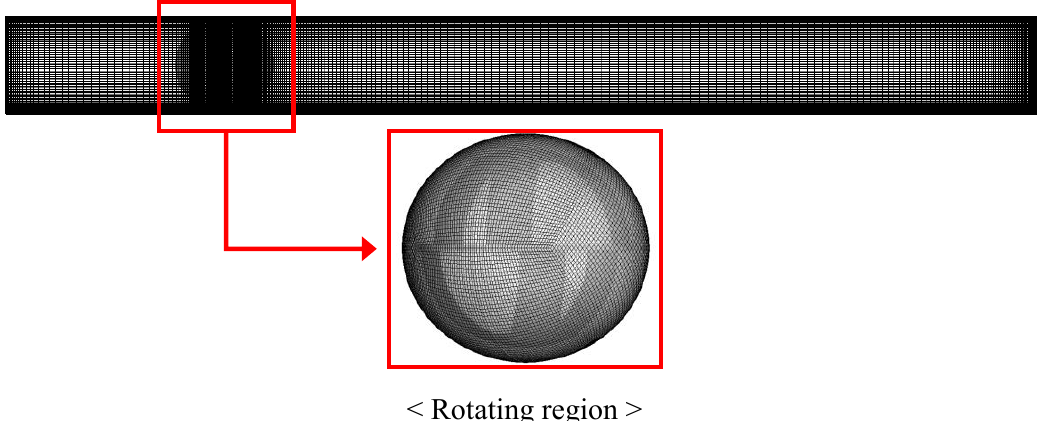
Figure 4. Vertical axis turbine installed in a water pipe: ( a ) side view and ( b ) top view.